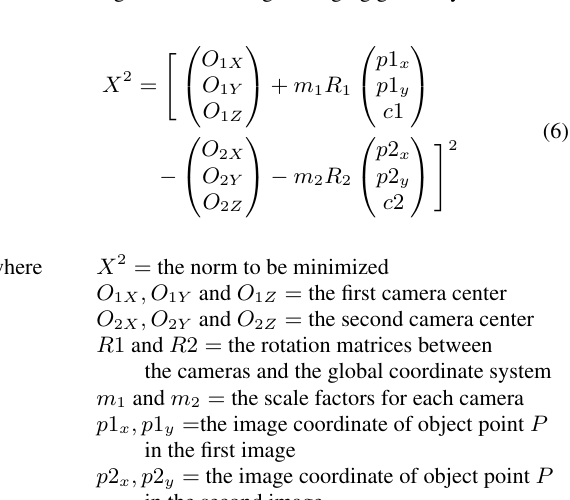
Figure 5: Two images imaging geometry